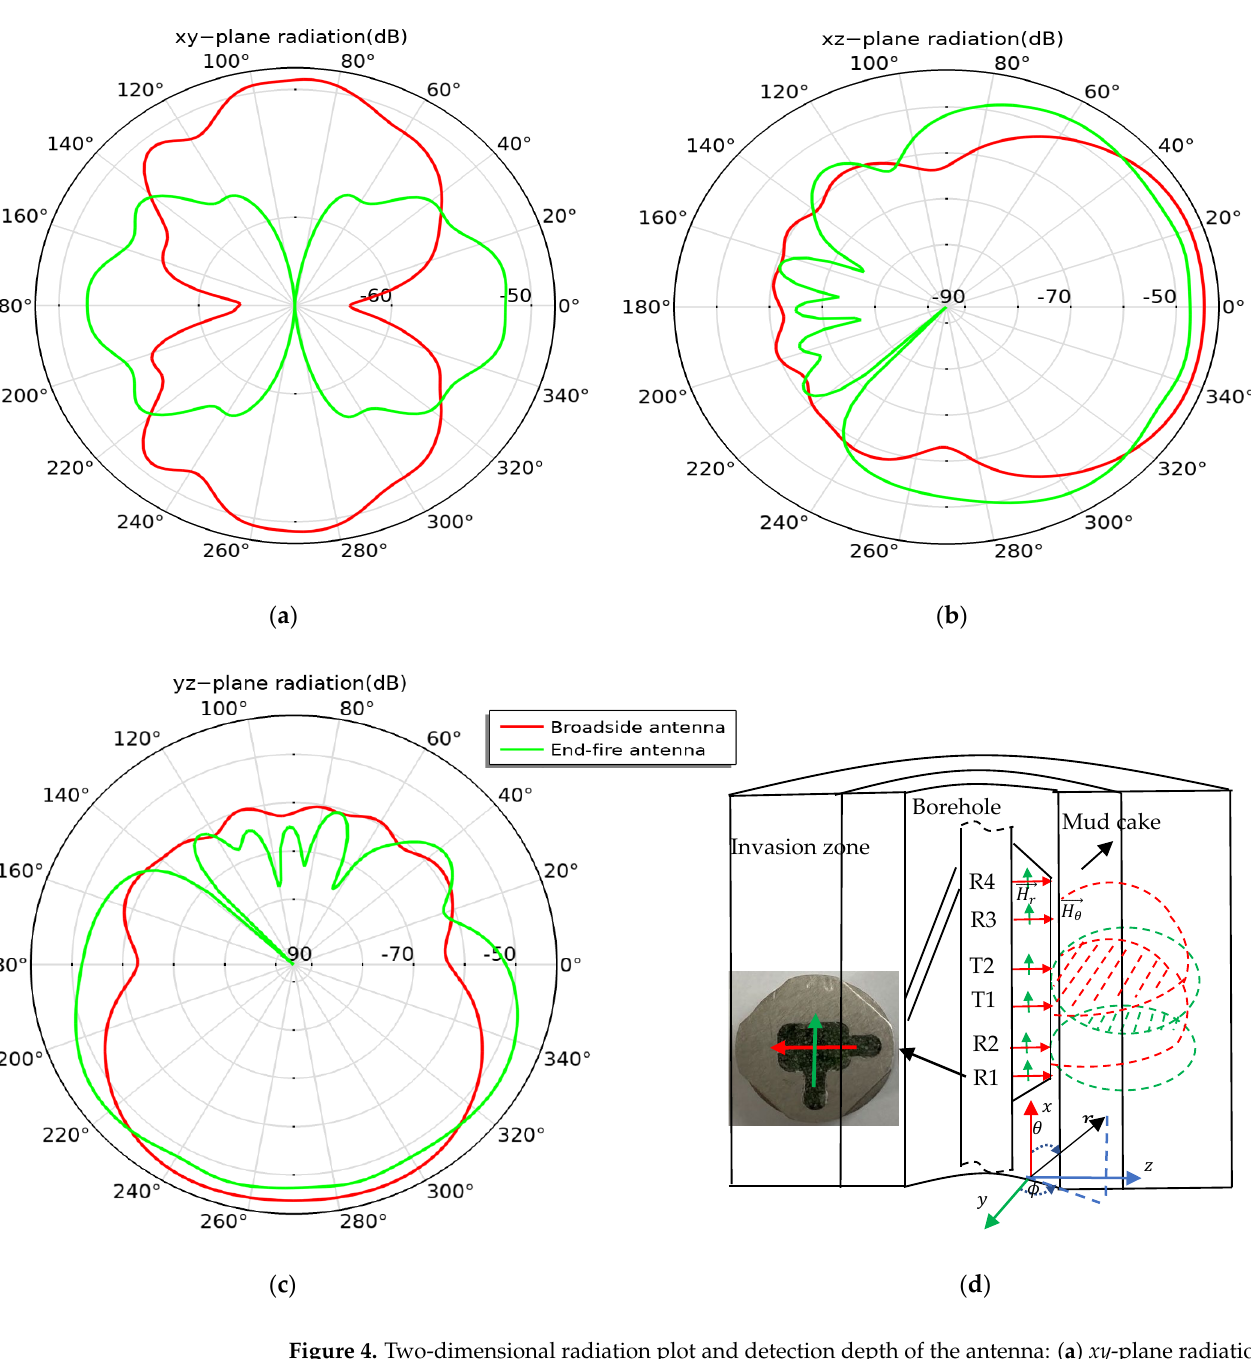
Figure 4. Two-dimensional radiation plot and detection depth of the antenna: ( a ) xy -plane radiation; ( b ) xz -plane radiation; ( c ) yz -plane radiation; ( d ) schematic diagram of detection depth of antenna.